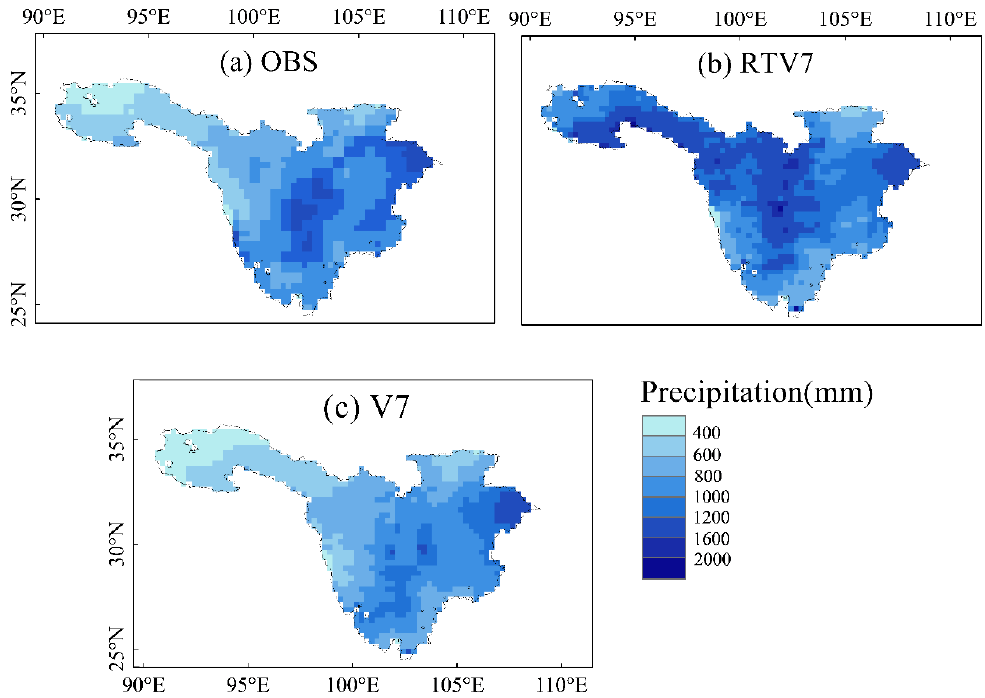
Figure 2. Spatial distribution of gauged precipitation and the Tropical Rainfall Measurement Mission (TRMM) Multi-satellite Precipitation Analysis (TMPA) precipitation for the annual mean value. The spatial distributions of the precipitation relative bias (%) from the TMPA 3B42RTV7/V7 data against the gauged precipitation data in the upper Yangtze reaches are shown in Figure 3. It can be found that the precipitation relative bias fluctuation of the 3B42V7 product was slight with a range between −30% and 10%, and over 66% (negative bias) parts of the spatial distribution of precipitation